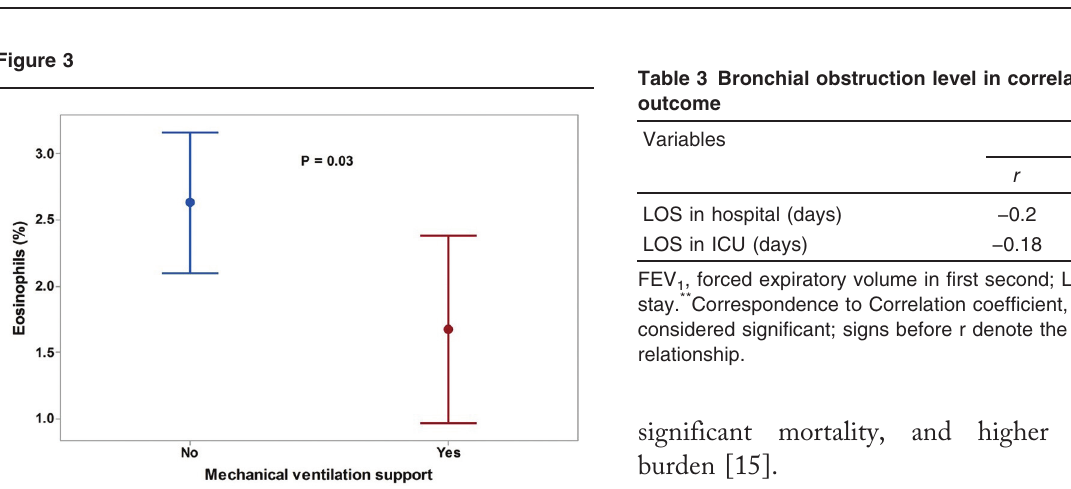
(a) Correlation of Eos% level with LOS in hospital. (b) Correlation of Eos% level with LOS in ICU. *Correlation coefficient, P < 0.05 considered significant, signs before r denote the direction of relationship. Eos, eosinophils; LOS, length of stay.